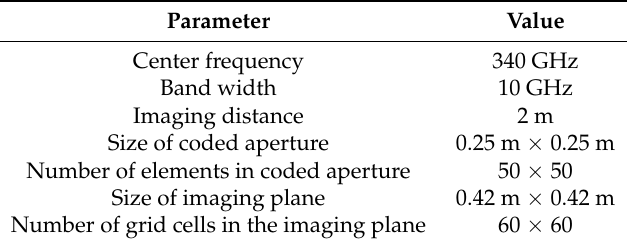
Table 1. Basic parameter settings used in the